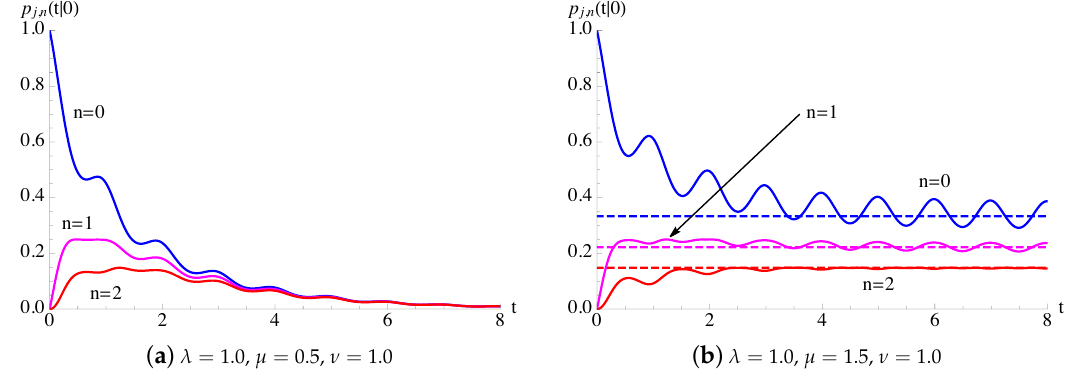
Figure 11. For the generalized Polya-death ( GPyD ) process, having λ n ( t ) = λ ( t ) ( n + ν ) and µ n ( t ) = µ n , with λ ( t ) given in (54), the probabilities p j , n ( t | 0 ) are plotted as function of t for j = 0, a = 0.9, Q = 1.0 and n =